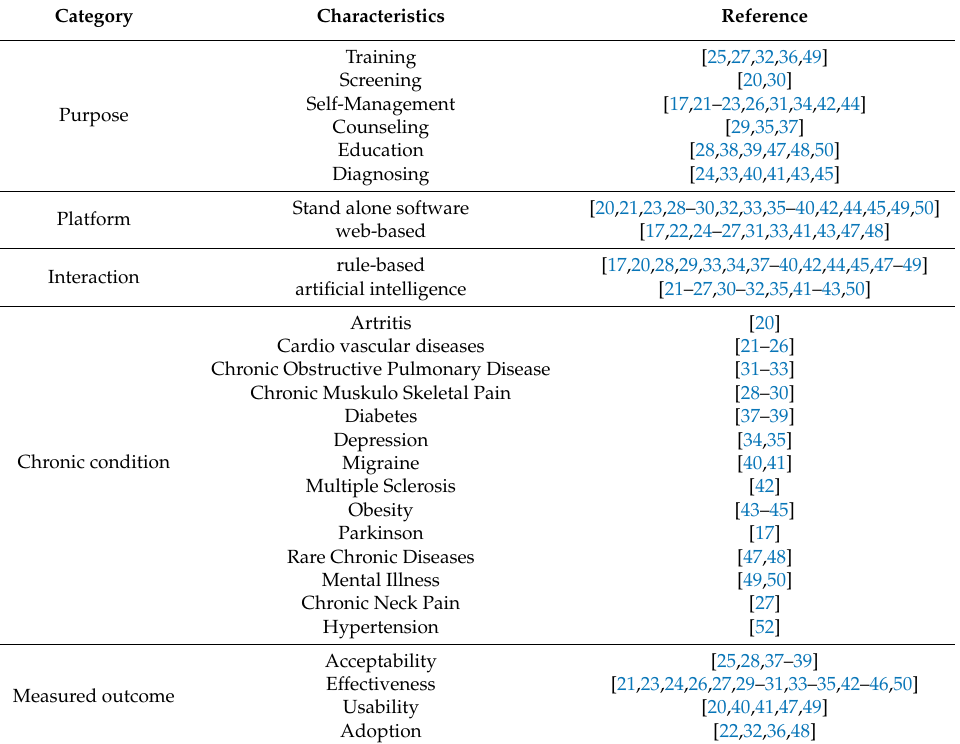
Table 3. Summary description of the different health coaching